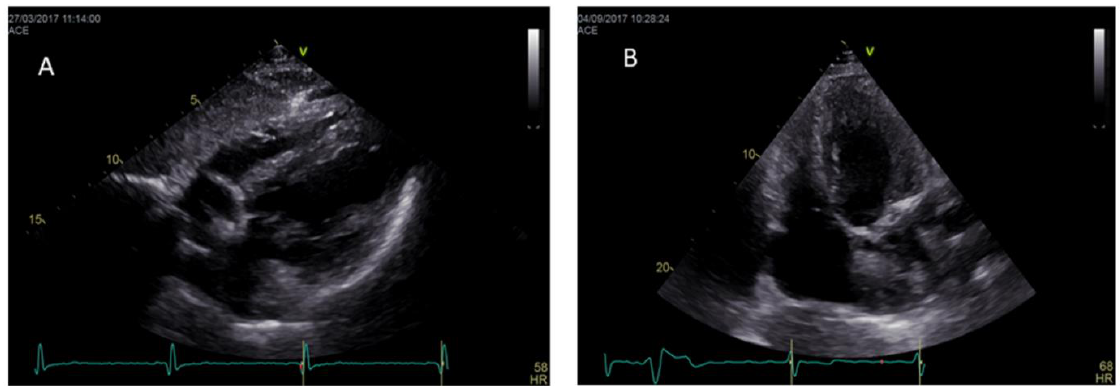
Figure 3. Hypertrophy of both the right and left ventricle in subcostal view ( A ) and in modified apical four chamber view ( B ) in two different AFD patients.